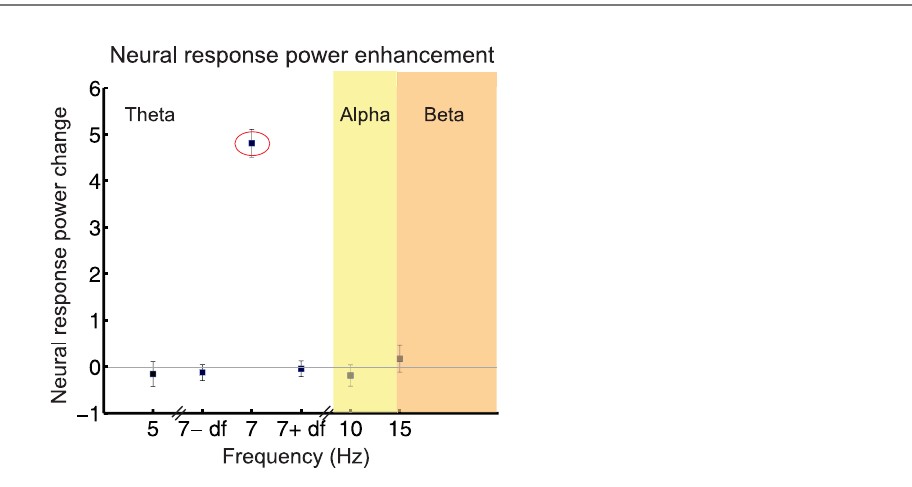
Fig. 6. Stream formation recruits more widespread brain areas at the target sequence rate. Power enhancement during the target task. The difference between the normalized neural responses in the target task versus the masker task (MEG experiment D, N 5 12) shows a significant and highly precise enhancement at the frequency of the target sequence (7 Hz, circled in red). Error bars represent 1 SEM in each